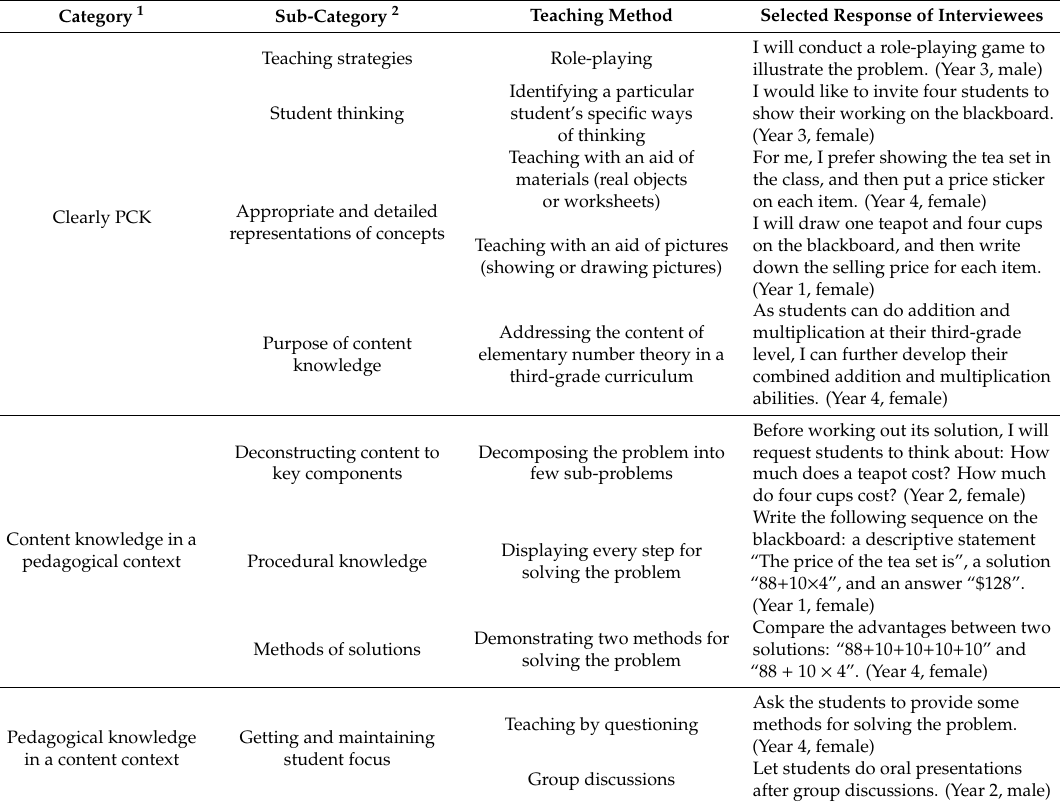
Table 2. Examples for interviewees’ MPCK in teaching a word problem for a class of third